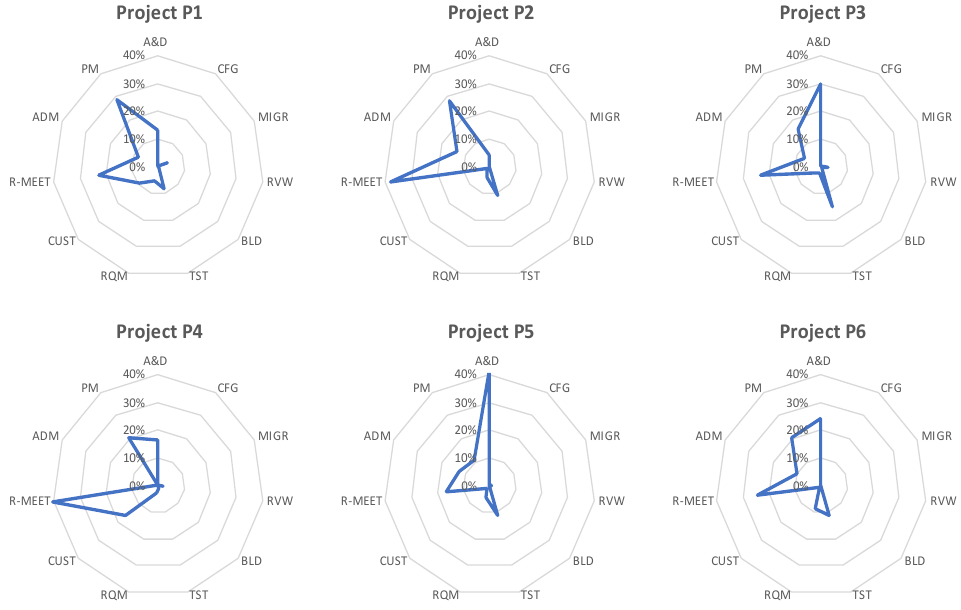
Figure 7. Structure of expenditure on recurring tasks in the researched projects. In most of the charts, the left organizational and management side dominates over the right developer side. The P1, P2, P3, and P6 projects follow a similar pattern in the recurring works chart, which indicates greater expenditure on meetings and management projects.